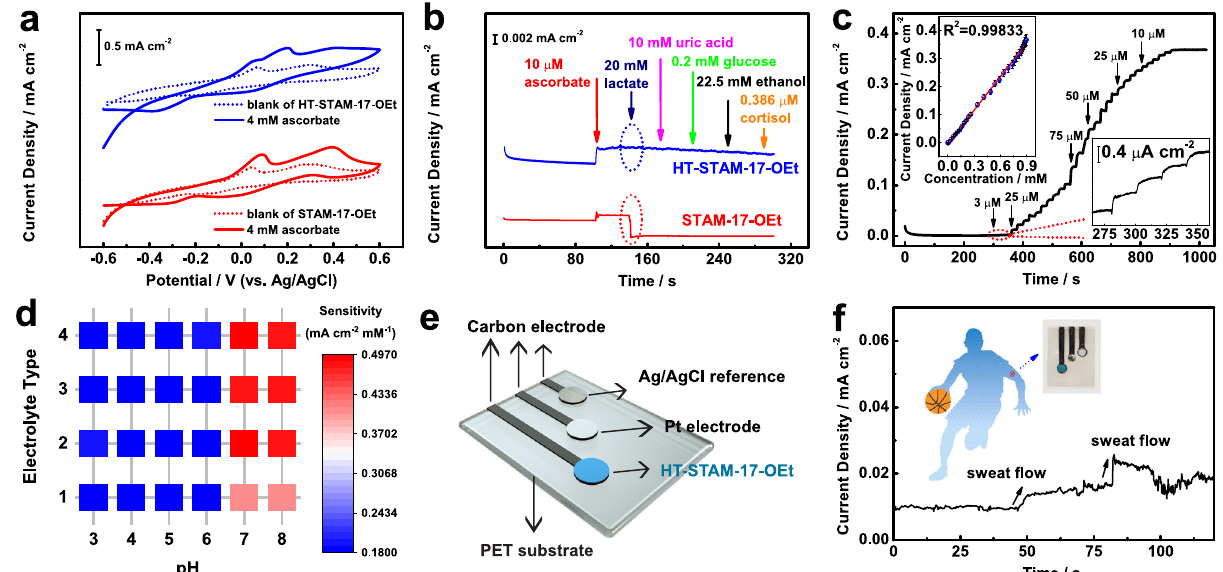
Fig. 3 | Electrochemical behavior and ascorbate sensing performances of HT- STAM-17-OEt. a CV curves and b amperometry response at 0.5V vs. Ag/AgCl for STAM-17-OEt and HT-STAM-17-OEt in 0.1M NaCl (pH=7) at 20mVs − 1 . c AmperometryresponseofHT-STAM-17-OEttosuccessiveadditionofascorbateat 0.5V vs. Ag/AgCl and the corresponding calibration curve (relative standard deviation was obtained from three groups of samples). d Sensitivity map of HT-